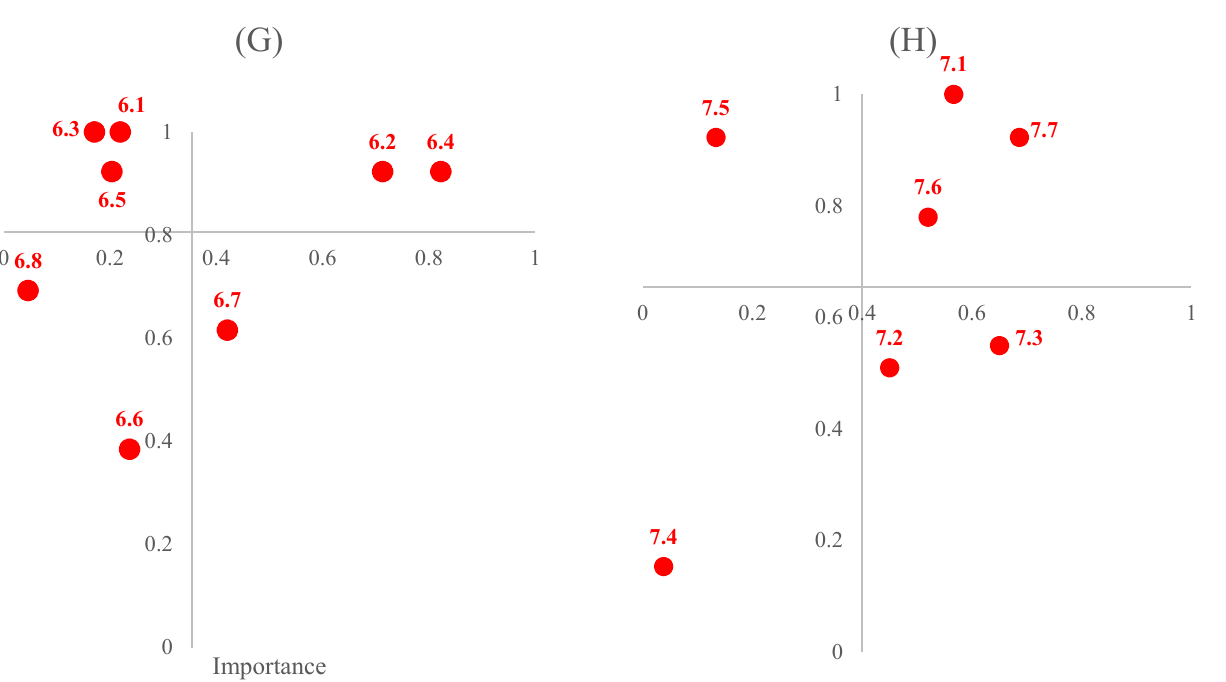
Figure 2. ( A ) The average score of each dimension. The green zone denotes a good level of safety allowing maintaining development. The yellow zone indicates that the dimension is at a fairly good level with a minor need of improvement. The orange zone means that the dimension is at a fairly low level with need of improvement. The red zone means that the dimension is at a low level with a major need of improvement. The IPA quadrants of ( B ) D1: Management’s Safety Priority and